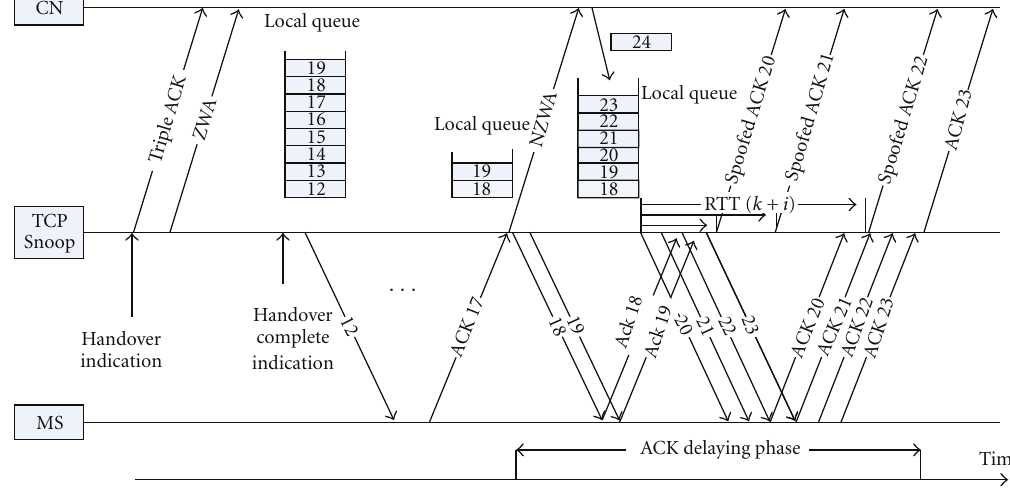
Figure 8: An example of TCP Snoop working procedure.